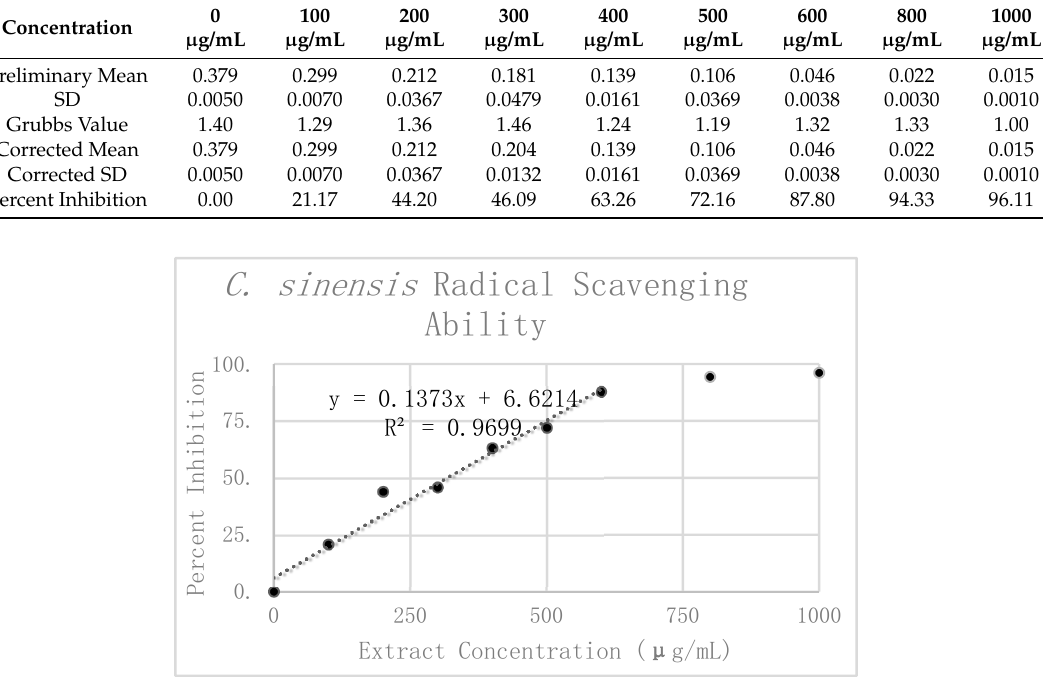
Table 1. DPPH assay raw absorbance data and calculated values for C. sinensis.